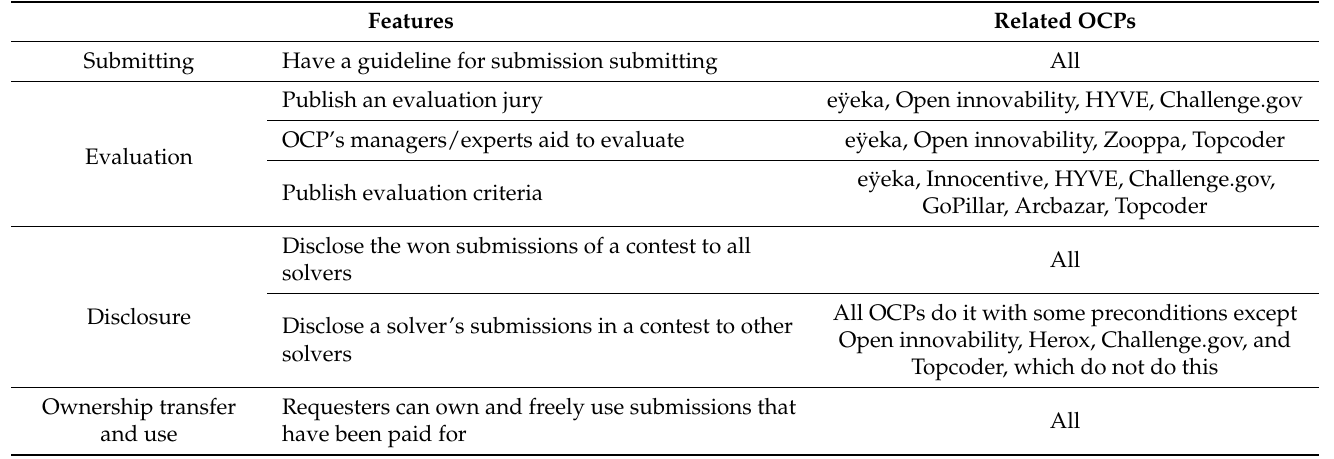
Table 2. The features of submission lifecycle